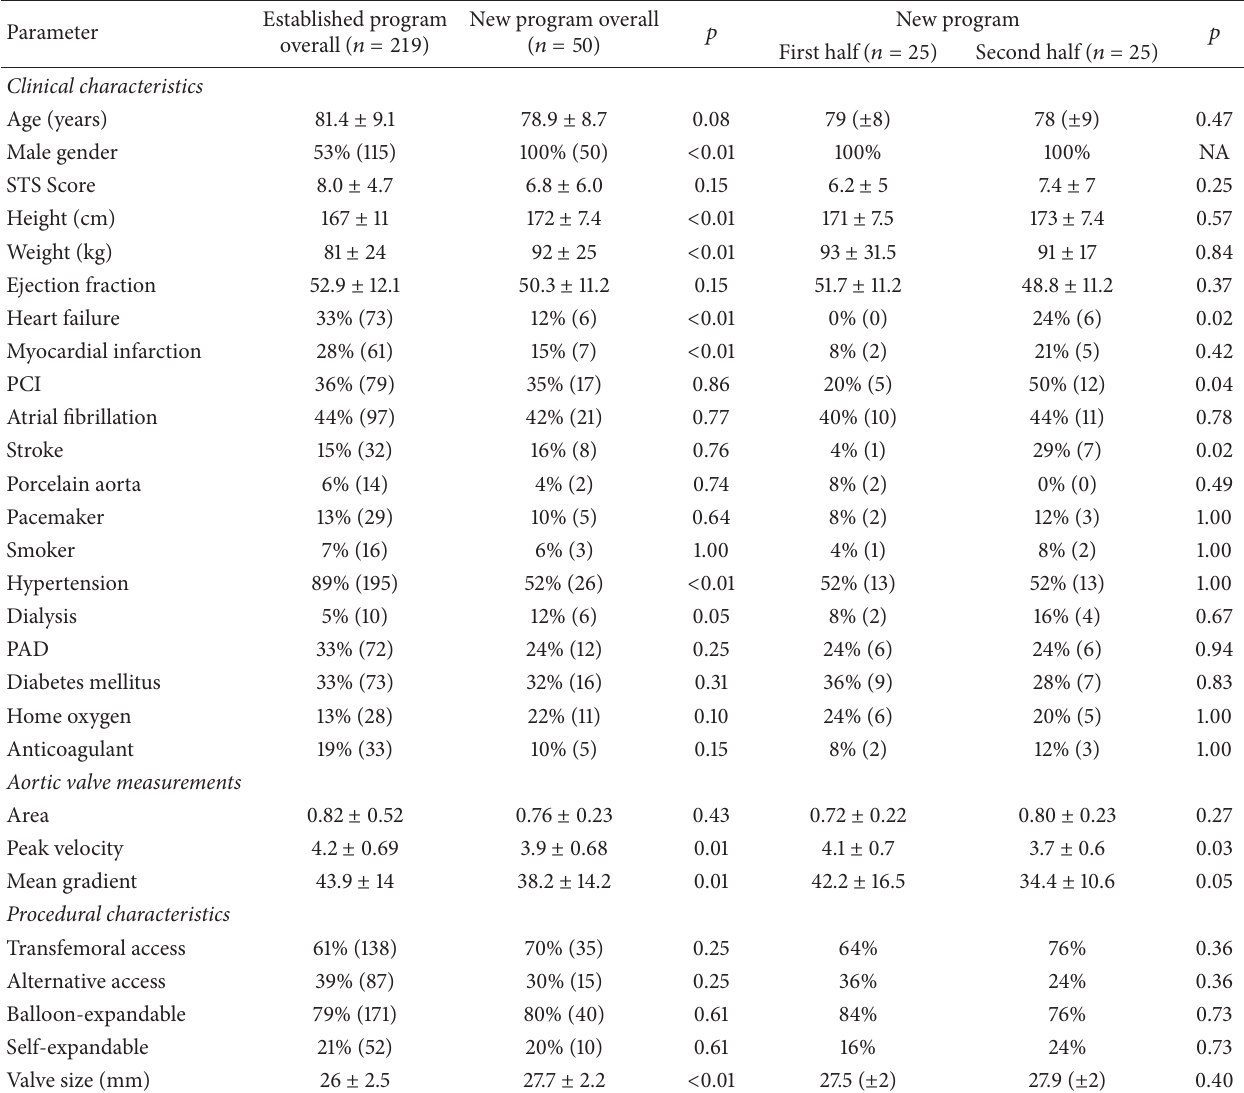
Table 1: Baseline characteristics.